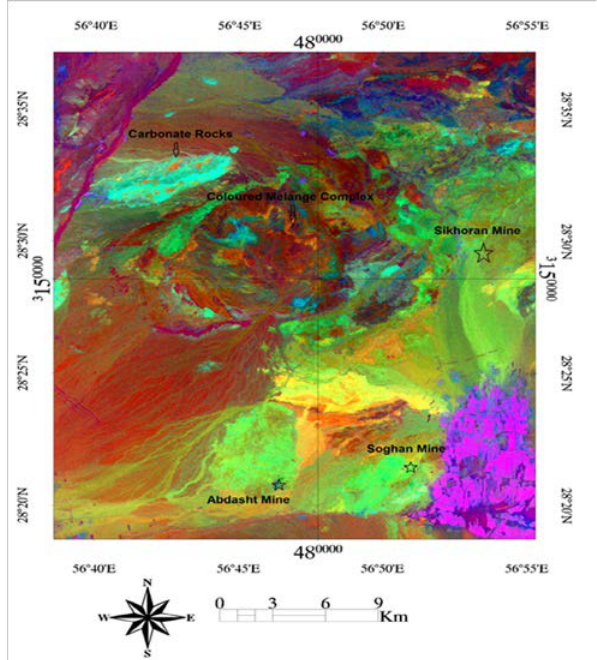
Figure 3. RGB color composites of MNF eigenimages 1, 2, and 3 extracted from the (VNIR+SWIR) ASTER data.